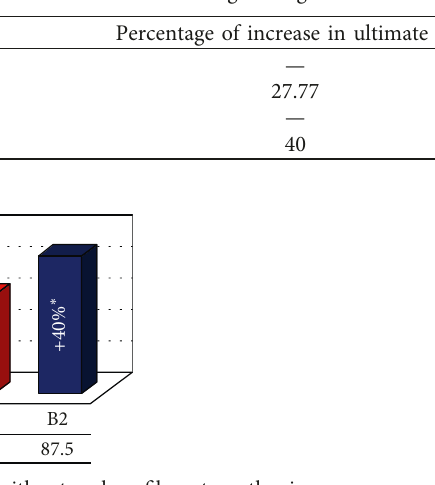
Table 7: Effect of clear span length on ultimate load with and without carbon fiber strengthening.